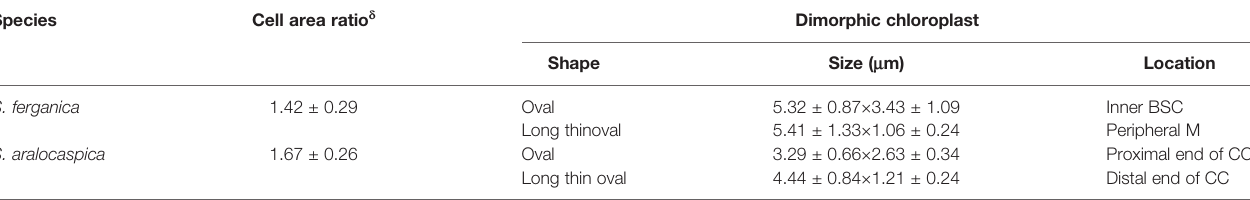
FIGURE 3 | The shapes and sizes of dimorphic chloroplasts in S. ferganica and S. aralocaspica . (A) S. ferganica ; (B) S. aralocaspica . Samples were collected from indoor plant. BS, bundle sheath; Ch1, chloroplast in MC ( S. ferganica ) or C d ( S. aralocaspica ); Ch2, chloroplast in BSC ( S. ferganica ) or C p ( S. aralocaspica ); C d , distal end of chlorenchyma cell; C p , proximal end of chlorenchyma cell; M, mesophyll. Scale bar is 10 m m. TABLE 3 | Properties of anatomic structures of mesophyll cells (MC), bundle sheath cells (BSC), chlorenchyma cells (CC), and dimorphic chloroplasts in S. ferganica and S. aralocaspica . Species